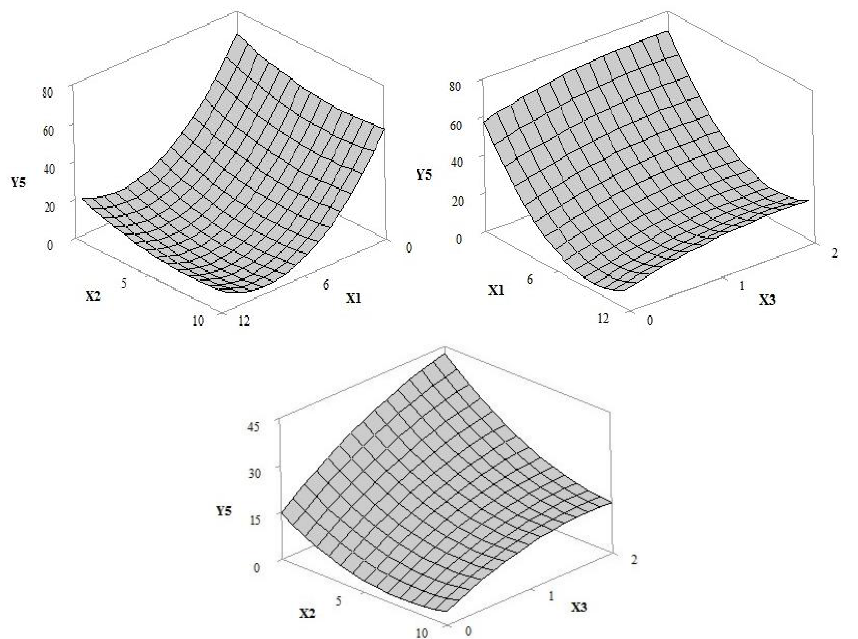
Figure 8. Response surface 3D plot of UVB protection (Y4) as a function of the concentration of UV filters: butyl methoxydibenzoyl methane—UVA, ethylhexyl methoxycinnamate–UVB and ethylhexyl dimethyl PABA—UVB of 0–12% w / w (X1), grape pomace extract concentration of 0–10% w / w (X2) and irradiation time of 1–2 h (X3).